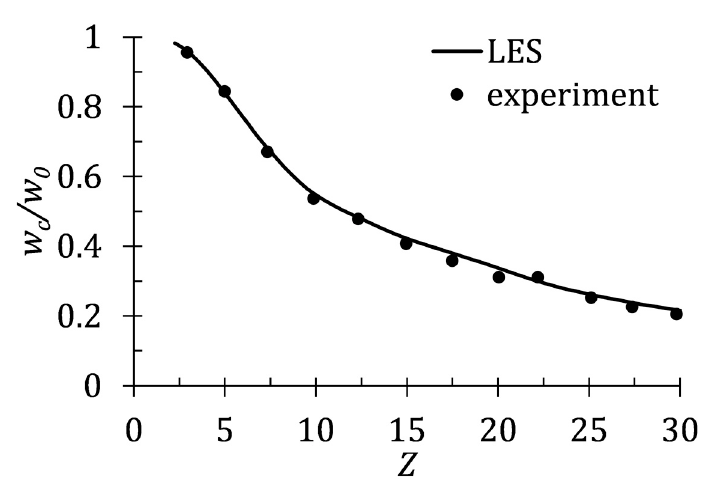
Figure 8. Comparison between numerical results and experimental results.